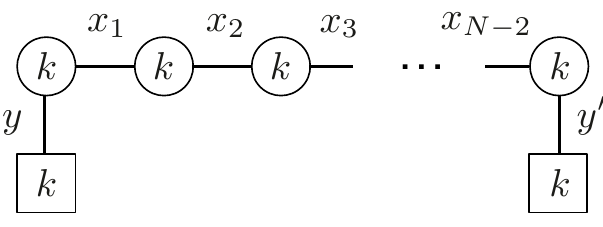
Figure 7 . Uniform quiver: N M5-branes on C 2 = Z